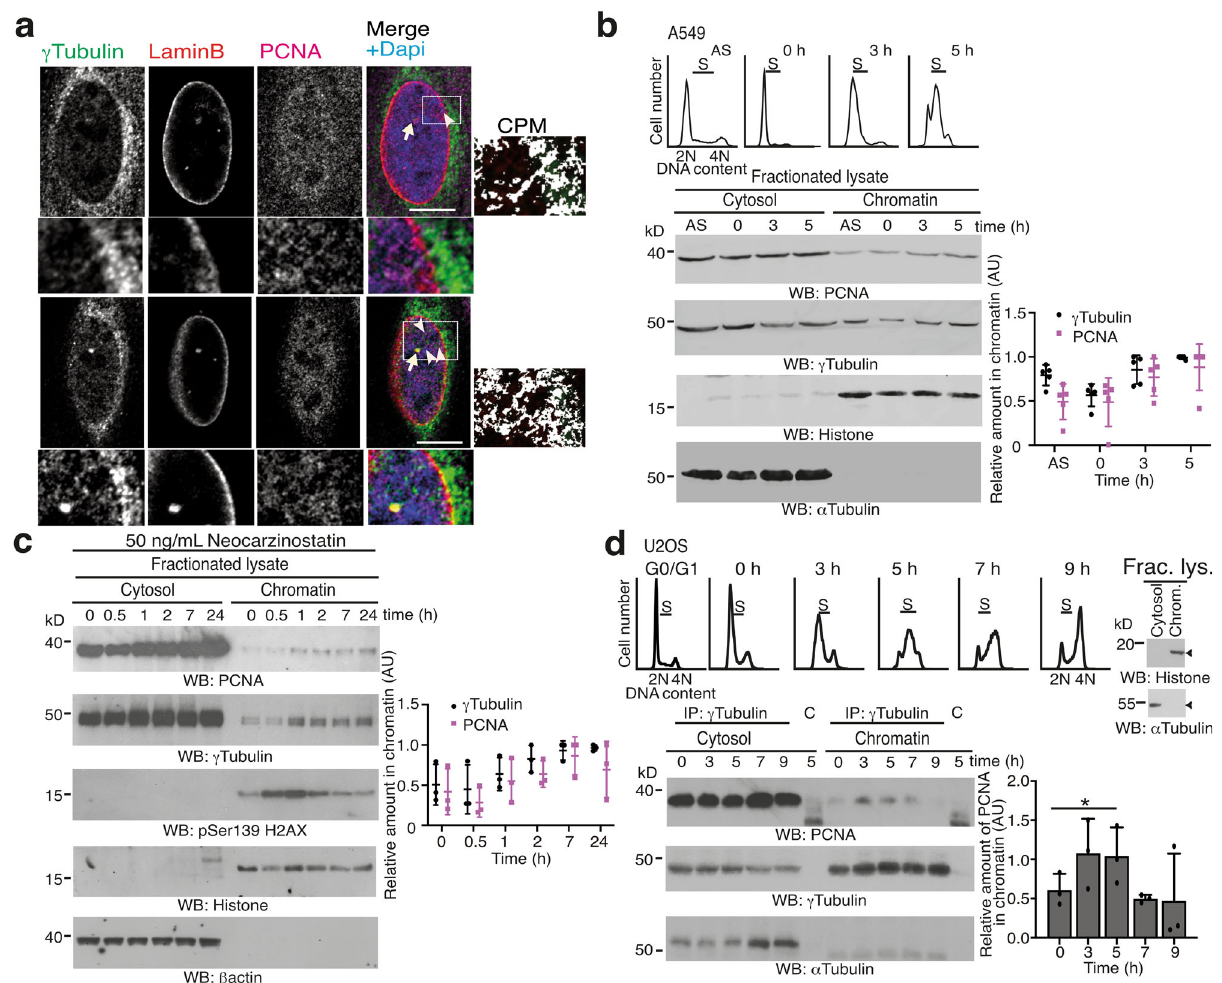
Fig. 2 γ -Tubulin interacts with PCNA. a Localization of γ -strings and PCNA in U2OS cells was examined by immuno fl uorescence staining with an anti- γ - tubulin, an anti-PCNA, and an anti-laminB1 (inner nuclear membrane protein) antibody. Nuclei were detected with DAPI. The confocal images show two different Z -planes from the nucleus of a cell. The white box indicates the magni fi ed area shown in the insets. Scale bars: 10 μ m ( N = 4 samples). Colocalization pixel maps (CPM) represent the magenta/red and green channels of the magni fi ed areas displayed in the inset. White areas denote colocalized pixels between channels. Arrowheads and arrows indicate γ -strings and centrosomes, respectively. b A549 cells (express γ -tubulin 1) were synchronized in early S phase by double thymidine block (0 h) and released for 3 h (early S) or 5 h (S). Cell cycle progression was monitored by determining the DNA content of cells with a nuclear counter (top panels). S phase synchronized and asynchronous (AS) A549 cells (1.0 × 10 6 ) were lysed, and proteins were biochemically divided into cytosolic, and chromatin fractions and then analyzed by western blotting (WB) with antibodies against PCNA, γ -tubulin, α -tubulin, and histone ( N = 5). c Biochemical fractions from neocarzinostatin-treated U2OS cells were examined by WB with the indicated antibodies against PCNA, γ -tubulin, phospho-histone2AX (marker of DSB), β -actin, and histone ( N = 3; see also Supplementary Fig. 1). d Using extracts from S phase synchronized U2OS cells, γ -tubulin was immunoprecipitated with an anti- γ -tubulin or an isotype-matched control (C) antibody and developed by WB with the indicated antibodies ( N = 3). The top panels illustrate the DNA content of the cells. Fractionated lysates (Frac. lys.) were run as control for the biochemical fractionation (right) and analyzed by WB using α -tubulin and histone as molecular markers for the cytosolic and nuclear fractions, respectively (see also Supplementary Fig. 2). The graphs in b – d illustrate densitometric analysis of the γ -tubulin and the PCNA chromatin content ( b , c ) or the content of PCNA in γ -tubulin immunoprecipitates from chromatin fractions in the presented WBs. To adjust for differences in protein loading, the concentration of a protein was determined as its ratio with histone ( b , c ) or with the immunoprecipitated protein ( d ) for each time point ( N = 3). Source data are provided in Supplementary Data